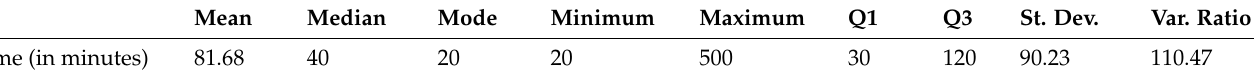
Table 2. Basic statistics for travel time.